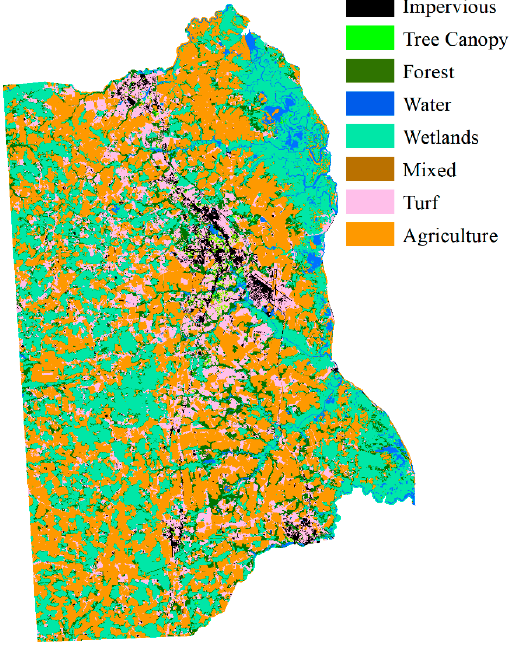
Figure 15. Land cover map of the aggregated pre-trained neighborhood spatial relationship and fuzzy classification membership result.